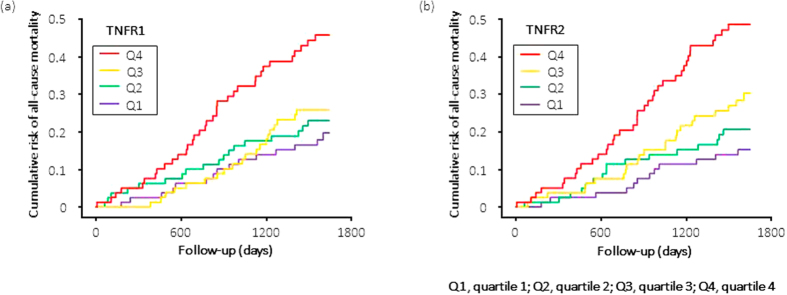
Cumulative risk for all-cause mortality in haemodialysis patients during 53 months of follow-up according to quartiles of circulating TNFR1 and TNFR2 at baseline.The cumulative risk for all-cause mortality steeply increased at a constant rate from the start of observation for patients in the highest quartile of TNFR1 (Fig. 2a) or TNFR2 (Fig. 2b).